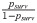
SHAP feature importance metrics for 4 patients that were correctly predicted as survived or deceased.Output values (bold), expressed as log odds ratio of probability of survival to probability of deceased (i.e. log(psurv1−psurv)), that are < 0 represent deceased patients (Cases A, C, D). Blue bars indicate that the feature value is increasing the probability of survival while red bars indicate that the feature is decreasing it.